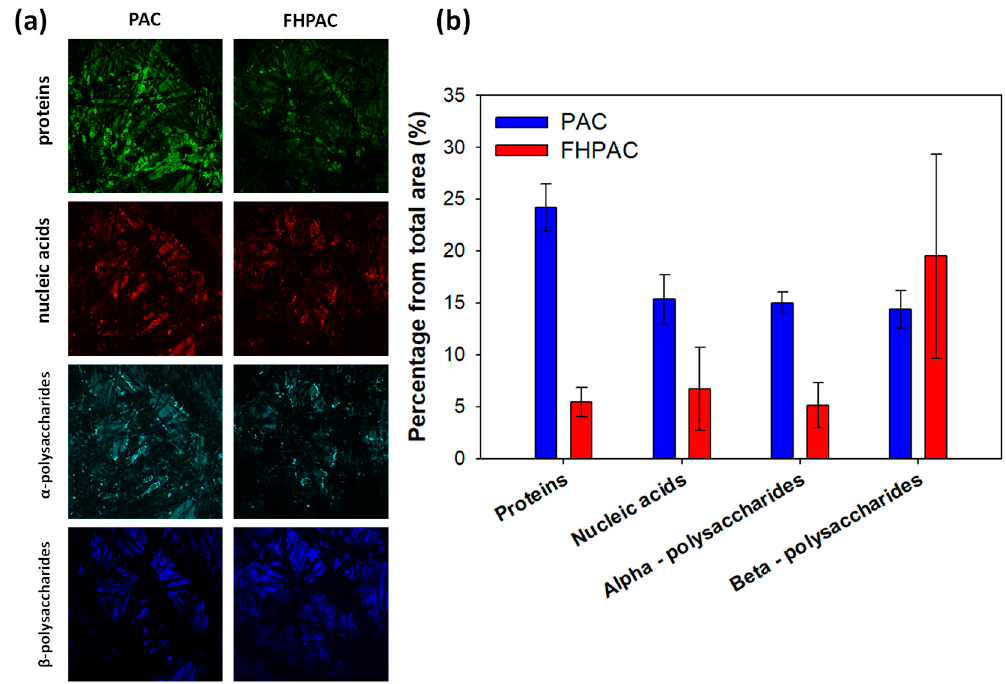
Figure 8. ( a ) CLSM images and ( b ) relative percentage in each chemical composition of PAN membranes with PAC and FHPAC adsorption. Each bar represents an average value. An error bar denotes 1SD.